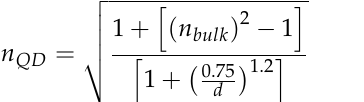
Figure 4. Emission peak positions against QD